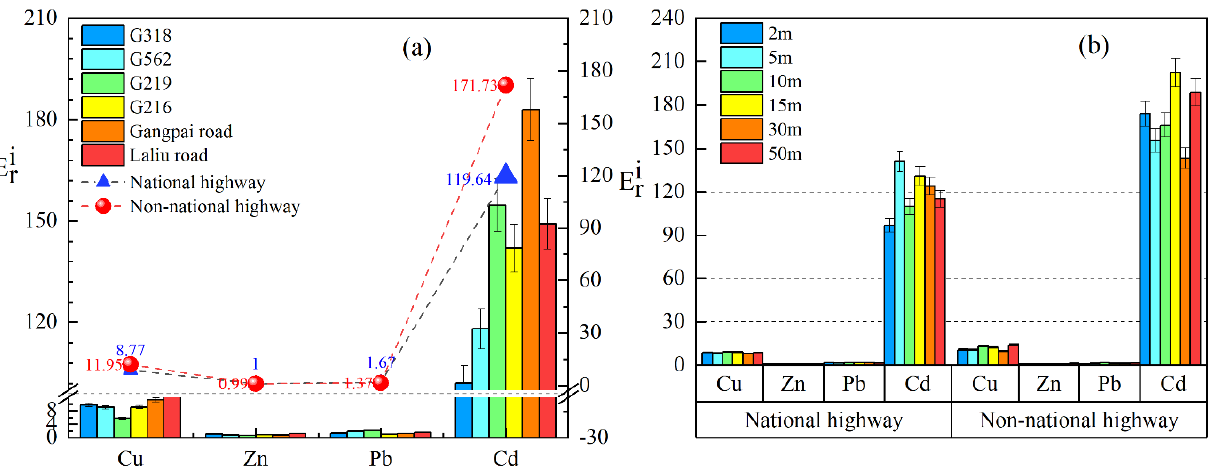
Figure 5. Single-factor potential ecological risk coefficients ( E i r ). ( a ) The average E i r values of soil heavy metals in different roads. ( b ) The average E i r values of soil heavy metals at different distances from national and non-national highways.